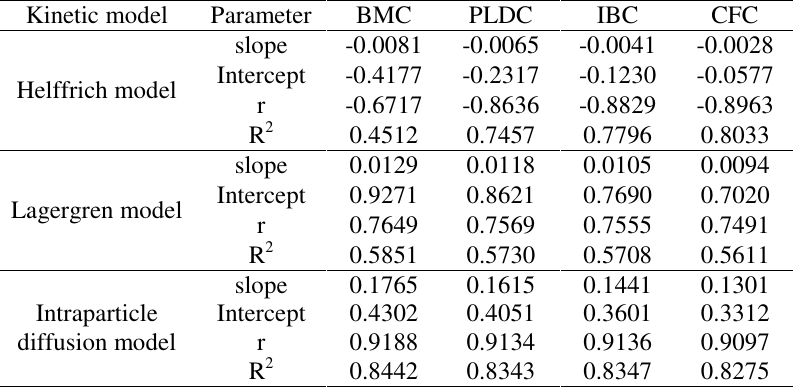
Table 4. Kinetic parameters of various models for the adsorption of